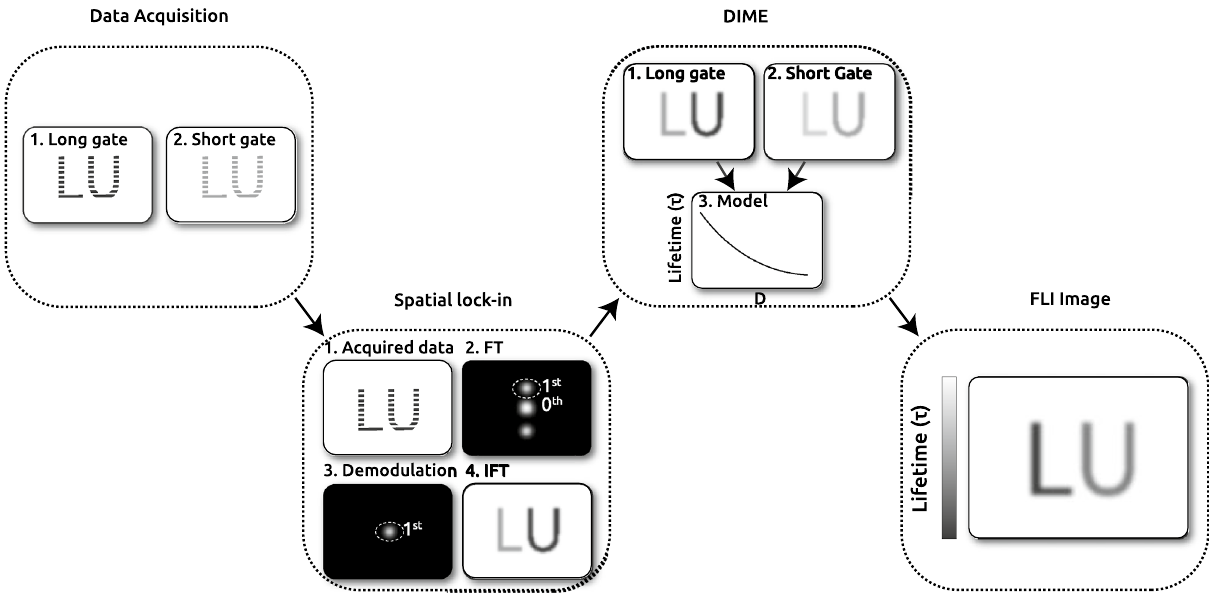
Figure 3. Flowchart of the methods applied in this study with graphical visualization of each method. (i) Data for long and short images were acquired during the experiment. (ii) The long and short images were analyzed using the spatial lock-in method to suppress scattering and remove the background. (iii) The DIME model is applied to the filtered images to extract (iv), the scattering and background-free FLI image.